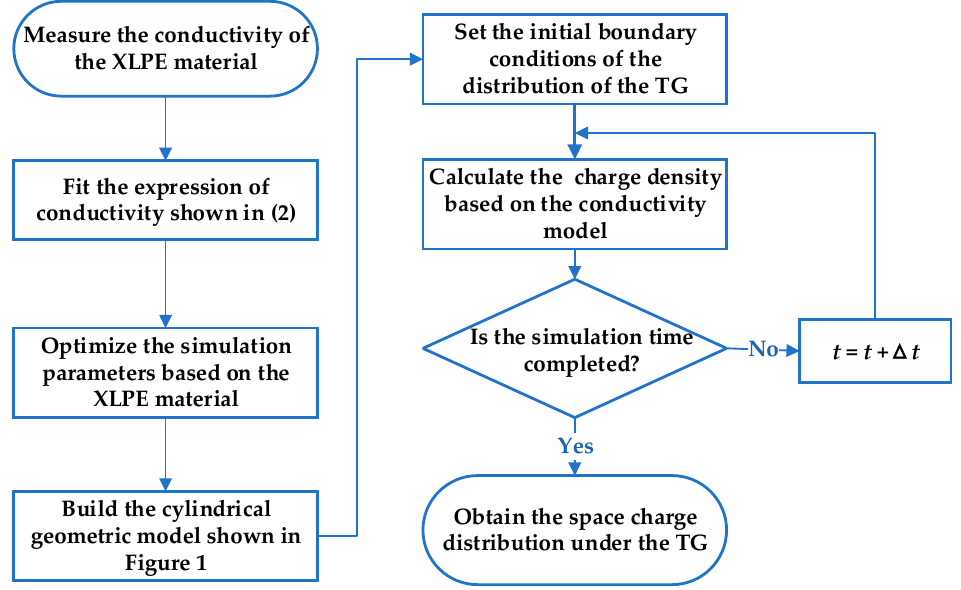
Figure 5. The flow chart of the simulation based on the conductivity model.